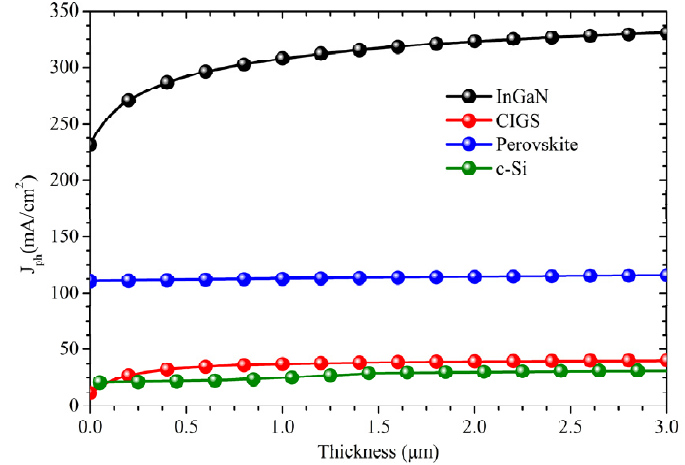
Figure 4. Photocurrent comparison between different materials with graded bandgap and the effect of the thickness in the J SC convergence [58,60,61].